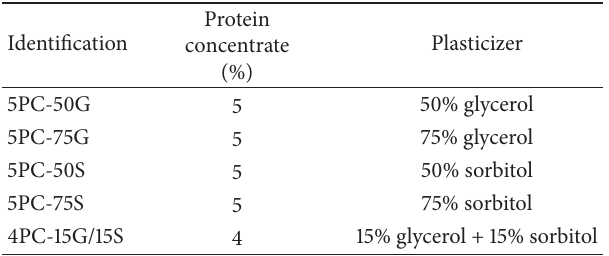
Table 1: Films formulations.